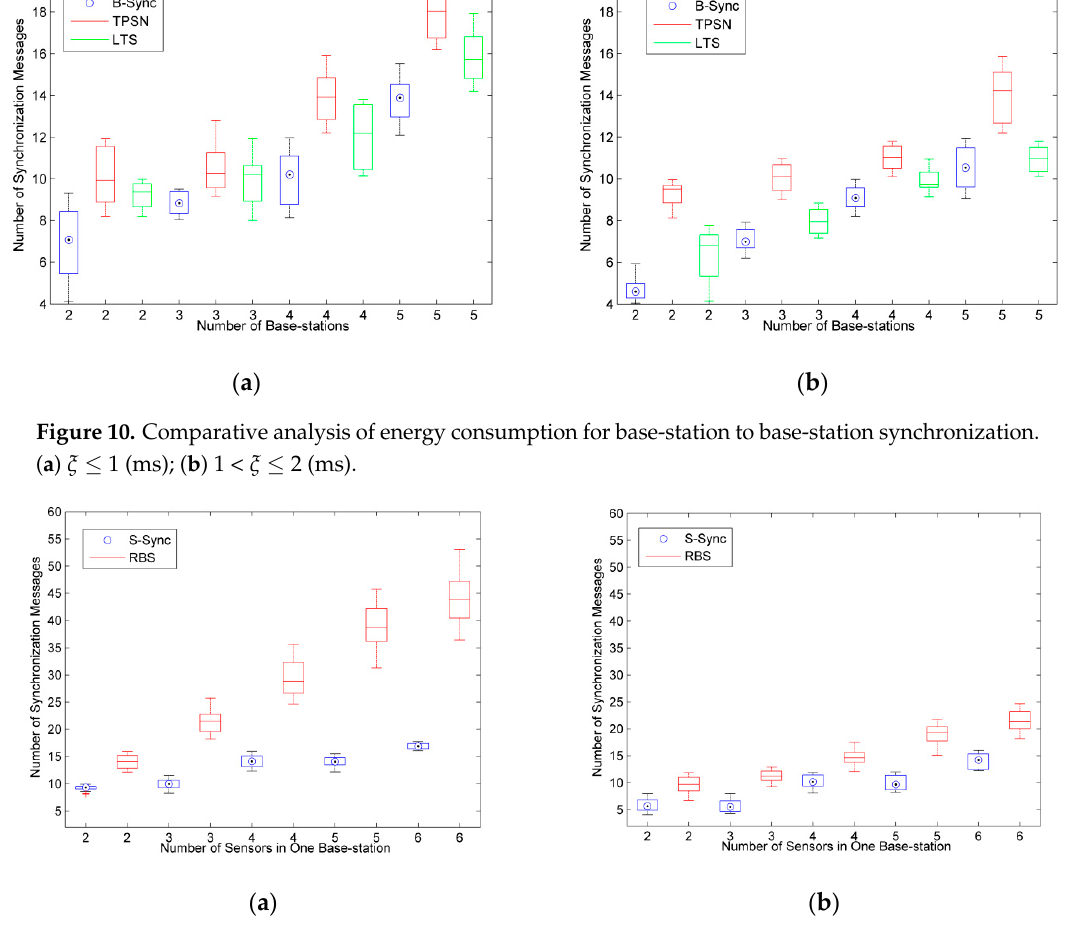
Figure 11. Comparative analysis of energy consumption for bases-station to sensor synchronization. ( a ) ξ ≤ 0.5 (ms); ( b ) 0.5 < ξ ≤ 1 (ms).